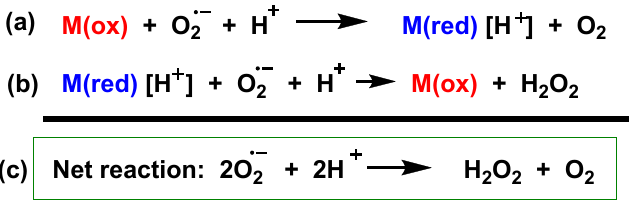
Figure 31. SOD-mediated reaction mechanism: ( a ) elimination of the first superoxide anion and reduction of copper; ( b ) second part of the reaction of transformation of the second peroxide anion into hydrogen peroxide and regeneration of the catalytic centre; ( c ) net reaction. Where M(ox) is the oxidized state of the metal in the catalytic centre (Cu 2+ Zn 2+ or Mn +3 ), and M(red) denotes the reduced state of the same metal (Cu + , Zn 2+ or Mn 2+ ).